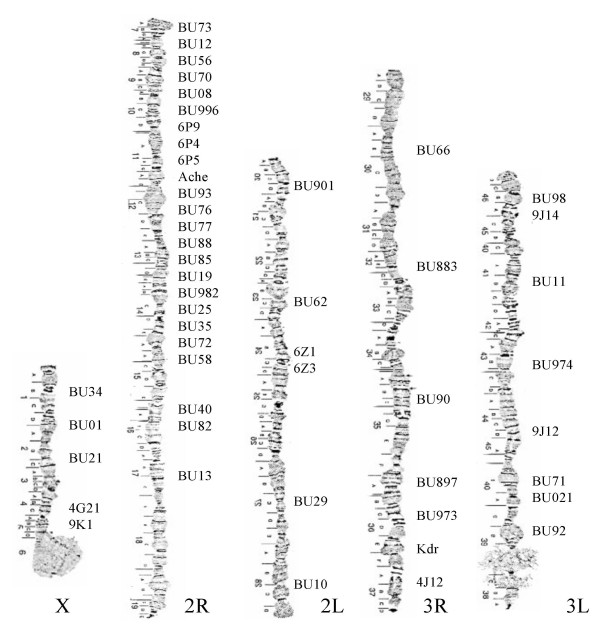
Relative location of studied genes on the An. funestus genome. For definitions of genes, see Table 4. This figure was adapted from [37].